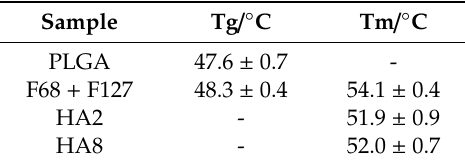
Figure 15. TEM images of HA2 and HA8 NPs.